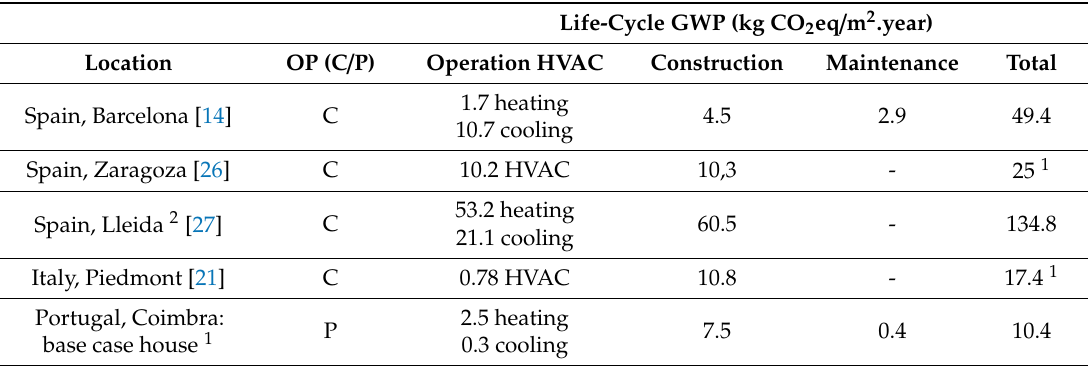
Table 7. Comparison of case study and literature life-cycle results for